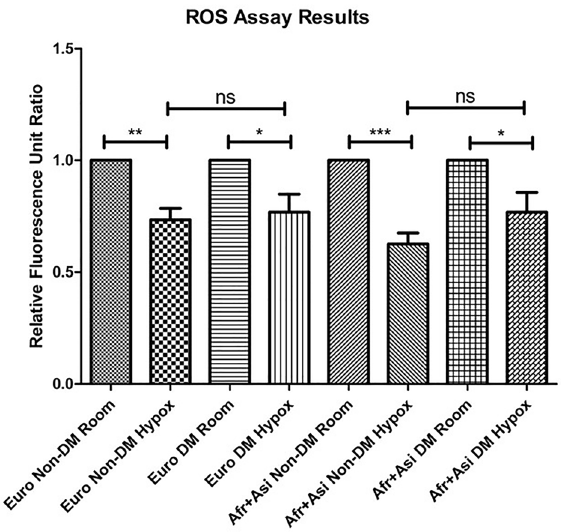
Figure 2. ROS levels decrease in hypoxia for European and [Afr + Asi], DM and Non-DM cybrids. ROS levels in cybrids cultured 48 h ± 2% O 2 was measured using an H 2 DCFDA-based assay. For each group of cybrids, data were normalized to relative fluorescence of cells cultured in room